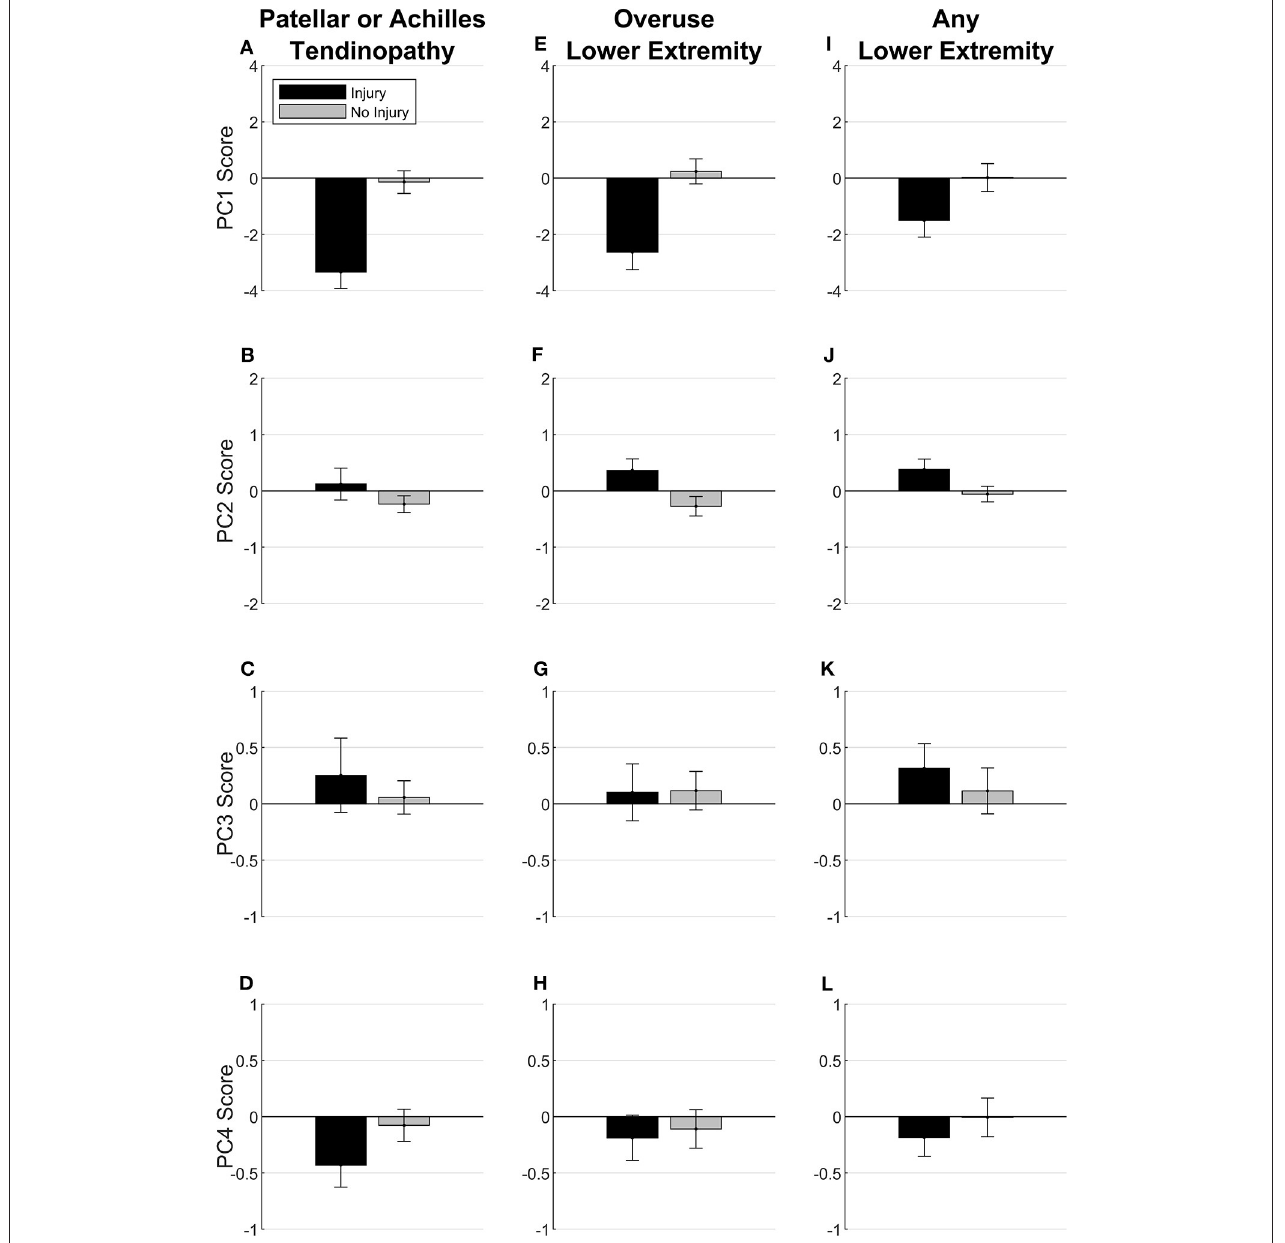
FIGURE 10 | Mean and standard error of PC scores for injured participants representing workload in the week before injury and the mean of all weeks until the last week where they did not experience any injury for uninjured participants. Visual comparisons are made for three separate injury classifications: (A–D) patellar or Achilles tendinopathy, ( E–H ) overuse lower extremity injury, ( I–L ) any lower extremity